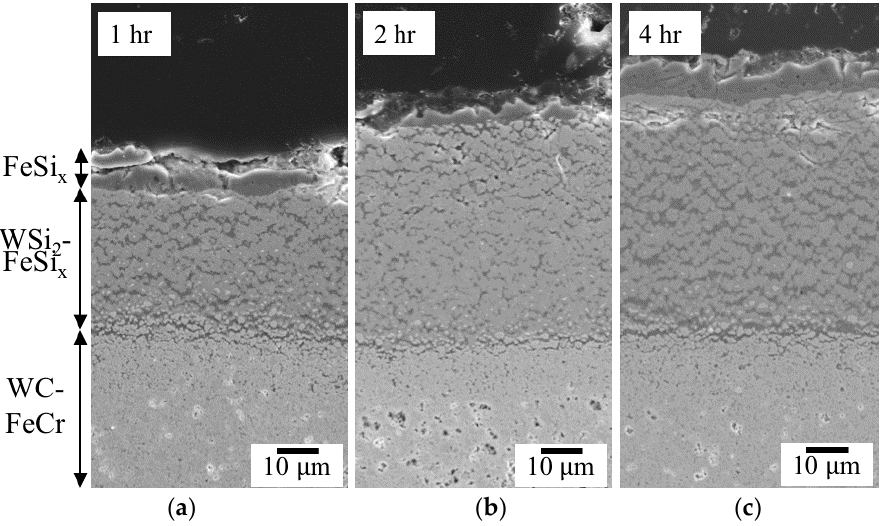
Figure 3. Cross sections of the coating after ( a ) 1, ( b ) 2, and ( c ) 4 h growth. The phase compositions of the coatings are indicated to the left.